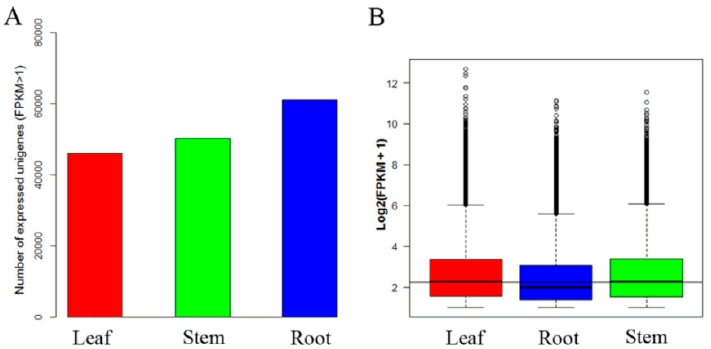
Figure 1. Overall expression profiles in C. chinense leaf, stem and root tissues. ( A ) Distribution of number of expressed unigenes (FPKM > 1) in tissues. ( B ) Boxplot of unigene expression in tissues. In ( B ), the x-axis represents tissue type and the y-axis represents log2 (FPKM + 1) values.